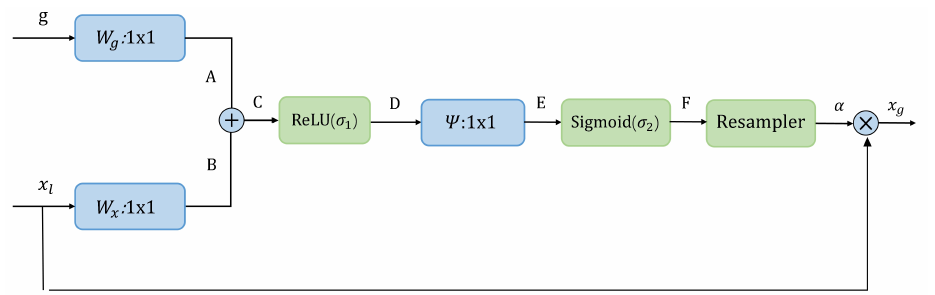
Figure 5. The architecture of the attention